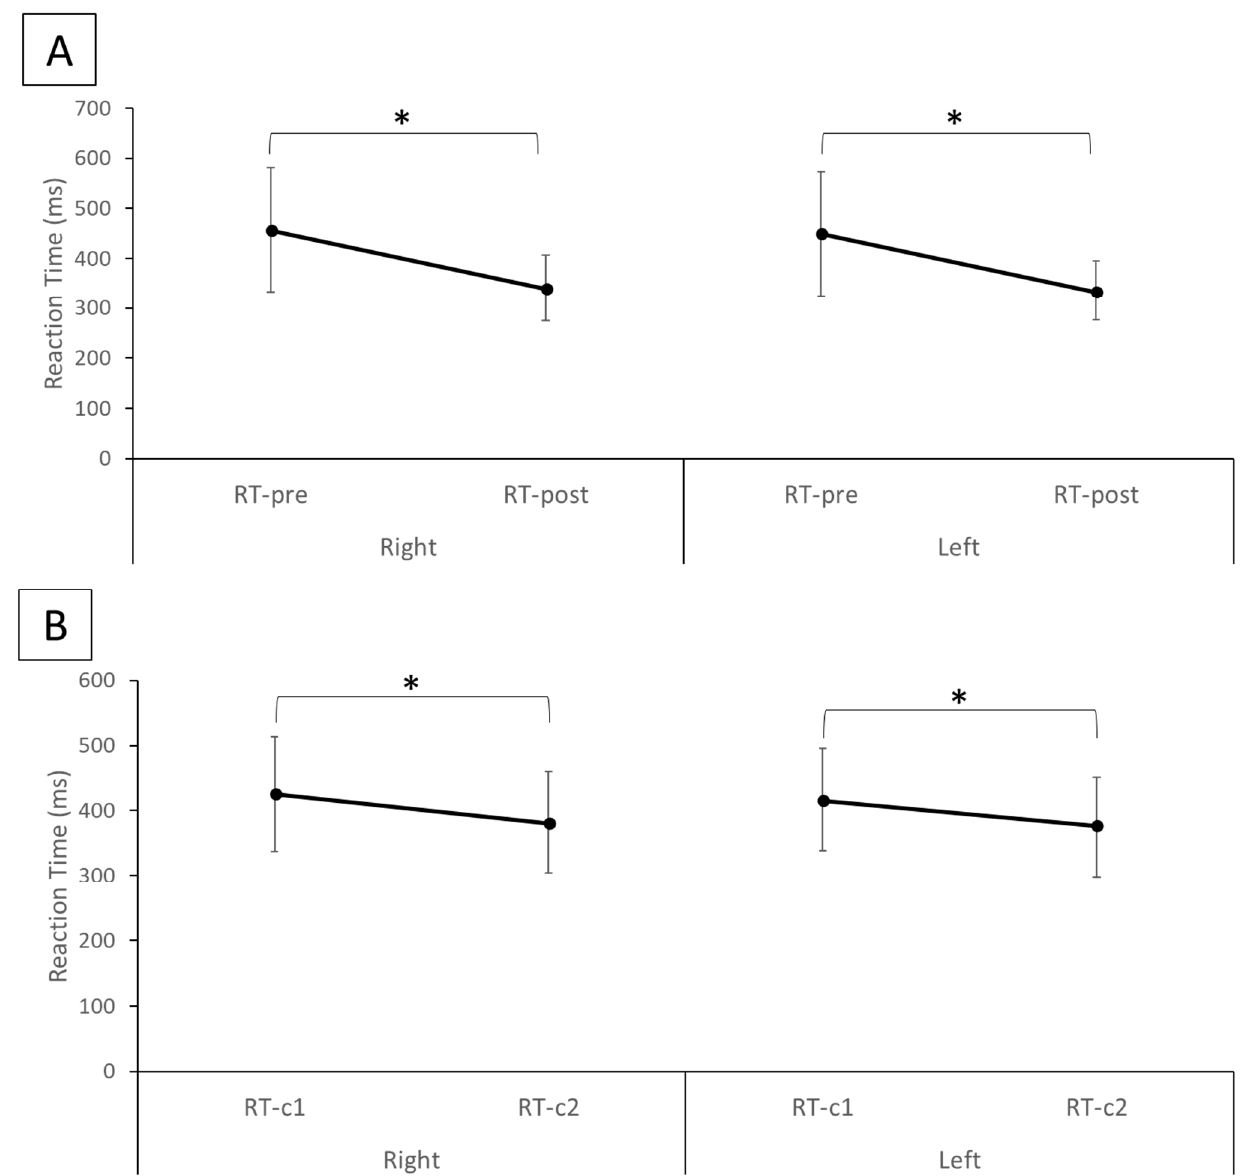
Figure 2. Mean ± SD reaction times for ( A ) the experimental group before (RT-pre) and after (RT-post) tactile imagery training and ( B ) the control group first five blocks (RT-c1) and last five blocks (RT-c2) of reaction time evaluation for the right and left hand. * Statistical significance with p < 0.05.